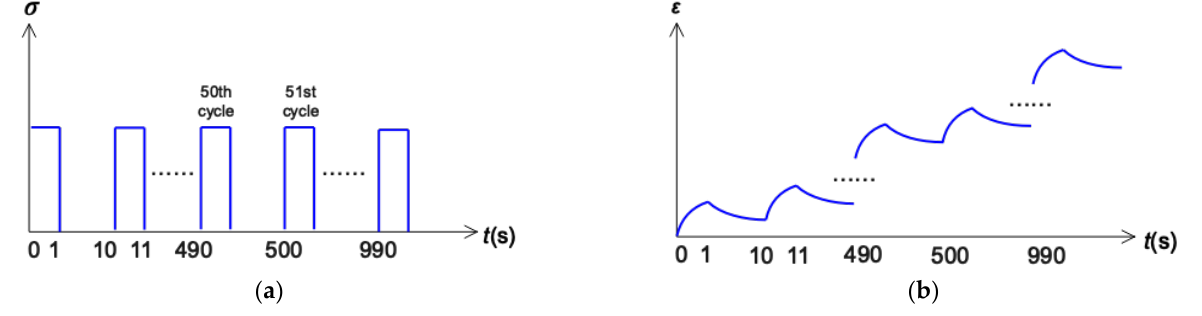
Figure 3. RCRT protocol: ( a ) stress and ( b ) accumulated strain.